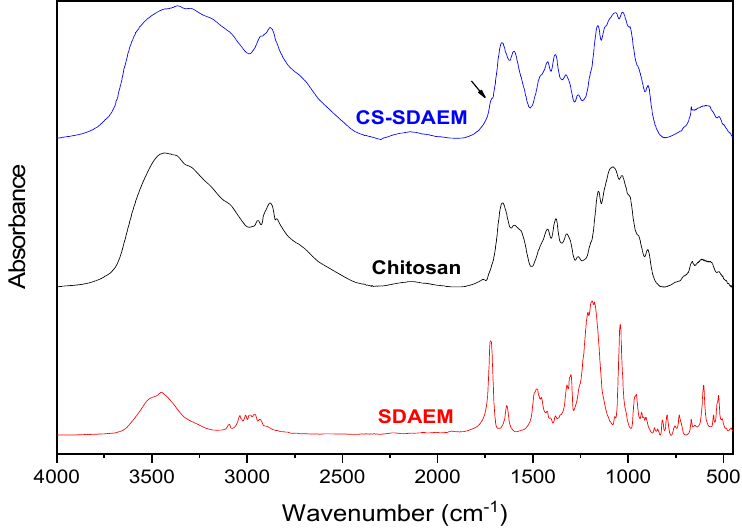
Figure 2. FTIR spectra of CS, SDAEM and CS-SDAEM